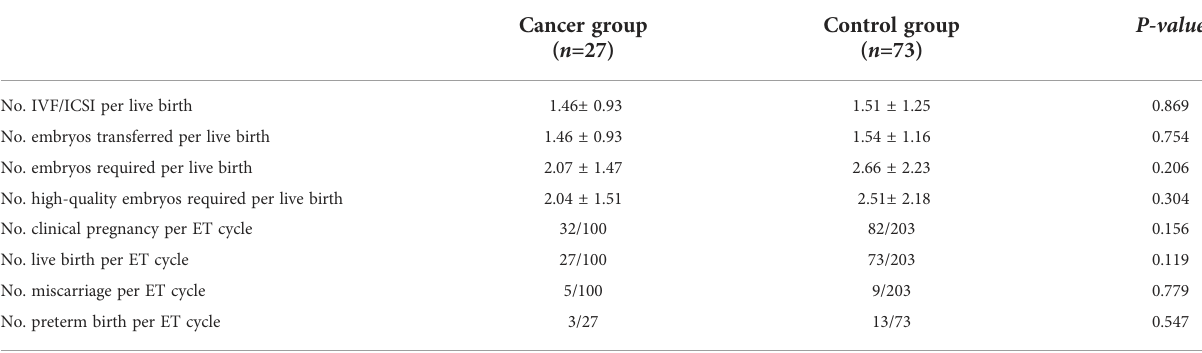
TABLE 3 Reproductive outcome.